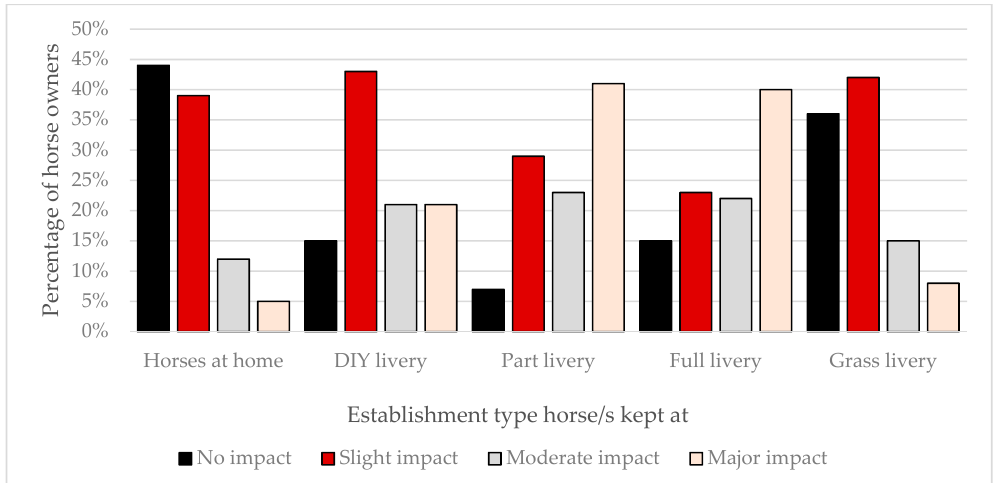
Figure 2. Impact of the coronavirus (SARS-CoV-2) pandemic on the management of United Kingdom (UK) horses by establishment type. Horse owners were asked to identify their perception of how much the COVID-19 pandemic had affected their normal day-to-day management of their horse/s. The data are grouped by the type of establishment.